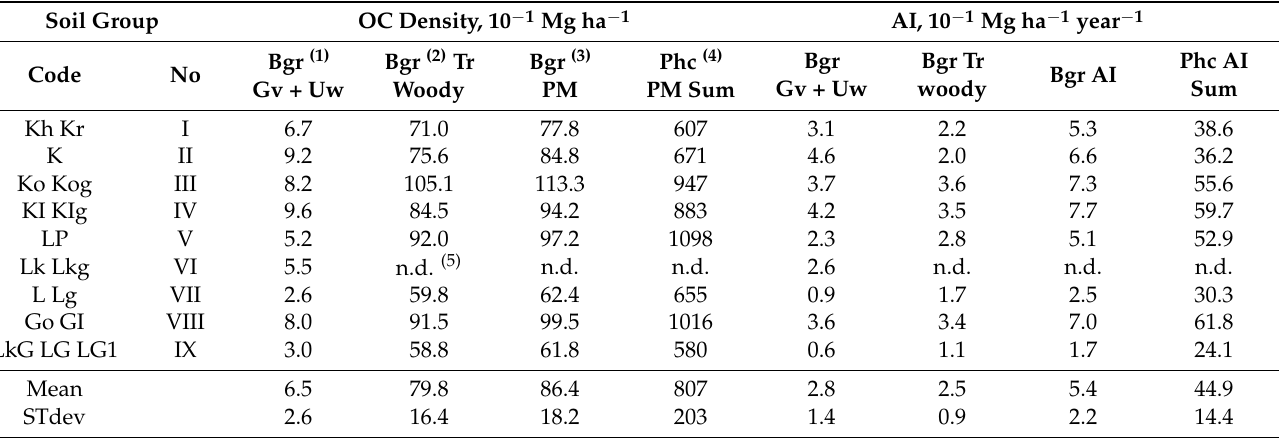
Table 6. Estimations of organic carbon in belowground phytomass (Mg ha − 1 ) and in its AI (Mg ha − 1 year − 1 ) for studied soil groups